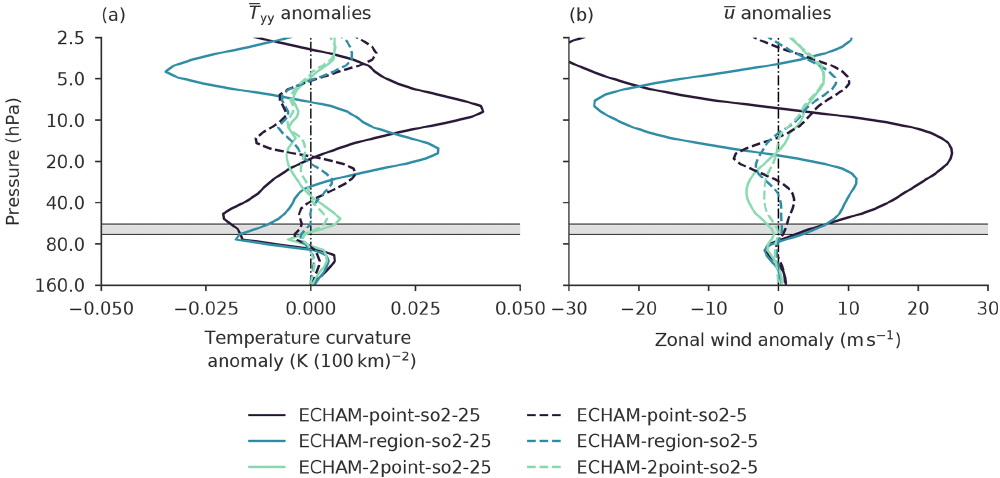
Figure 7. Vertical profile of the 5 ◦ N to 5 ◦ S mean anomaly of the temperature curvature T yy (a) and the tropical mean anomaly of the zonal wind u (b) for the ECHAM simulations of a SO 2 injection with an injection rate of 5Tg ( S ) yr − 1 (dashed) and 25Tg ( S ) yr − 1 (solid). The horizontal grey bar marks the injection layer. The vertical dashed–dotted line marks an anomaly of 0K ( 100km ) − 2 (a) and 0ms − 1 (b) .